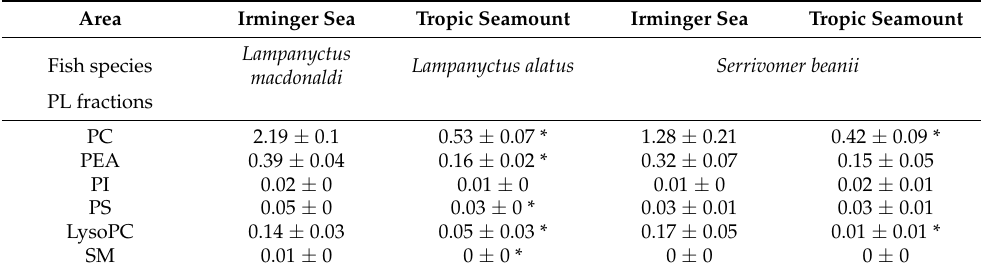
Table 2. The content of certain phospholipid fractions (% dry weight) in muscle tissue of mesope- lagic fishes from Irminger Sea and Tropic Seamount.